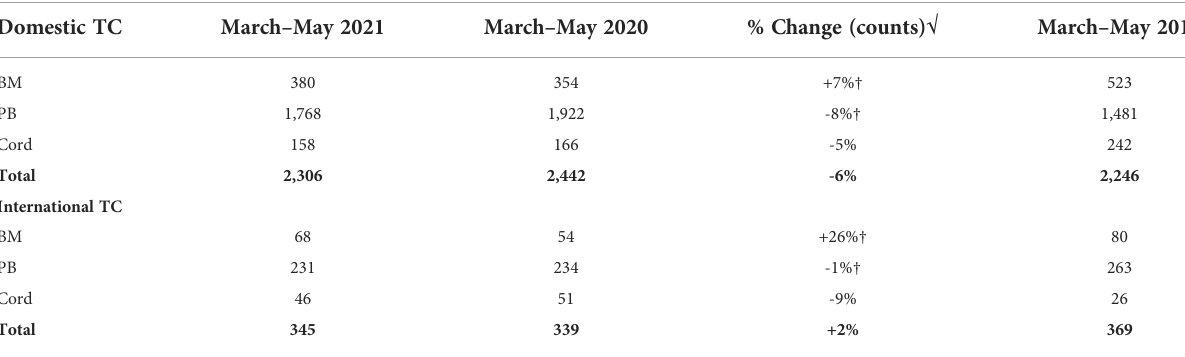
TABLE 3 Types of graft requested during the COVID-19